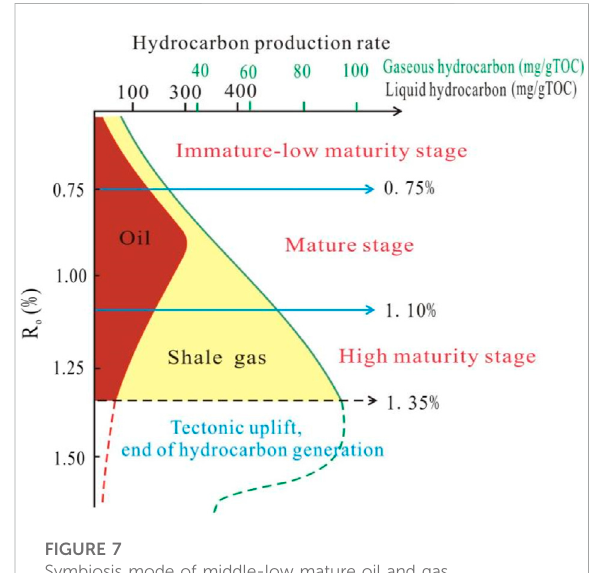
FIGURE 7 Symbiosis mode of middle-low mature oil and gas.